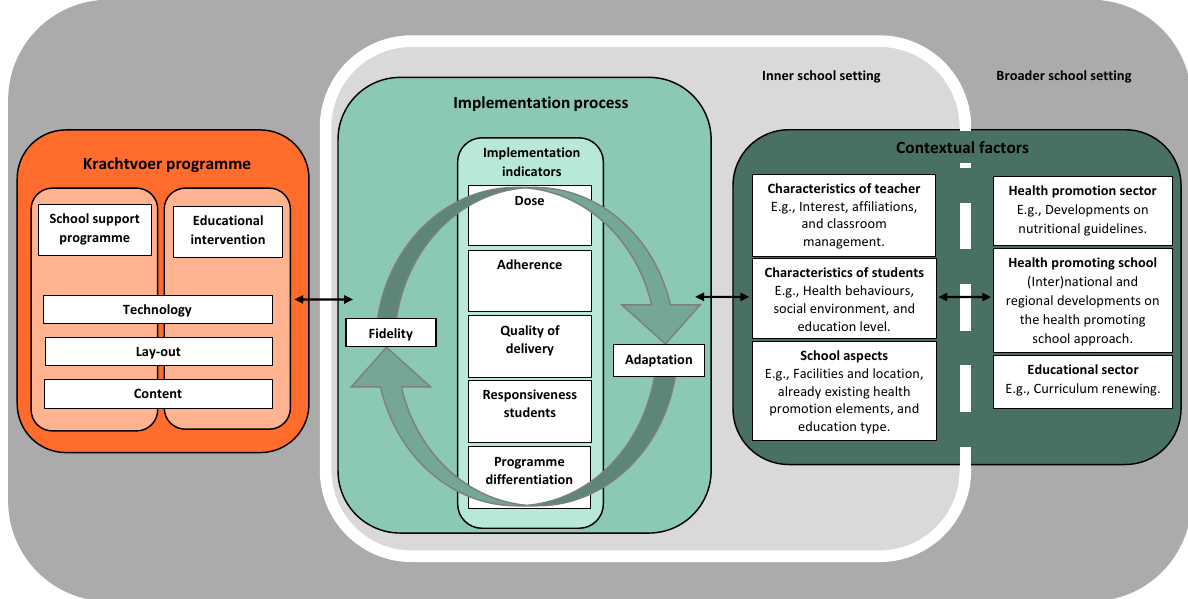
Figure 1. Conceptual framework of contextual